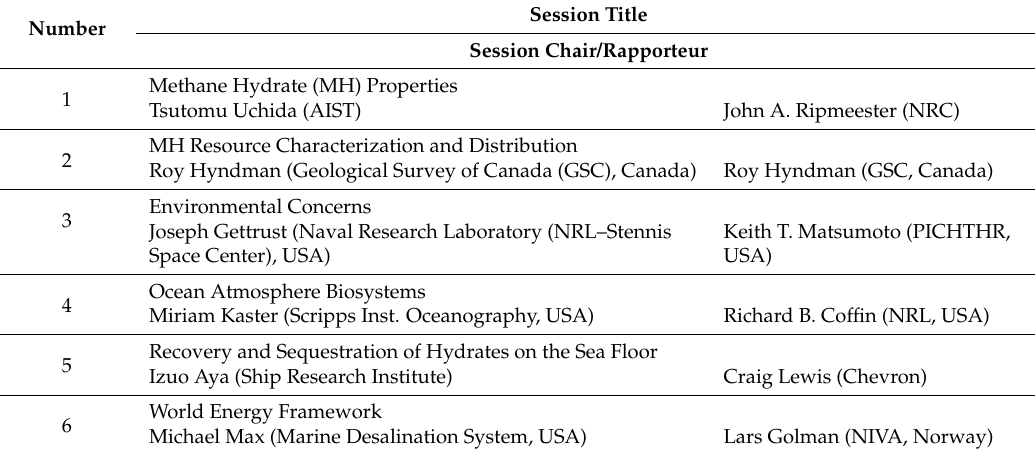
Table 2. Breakout sessions (title and